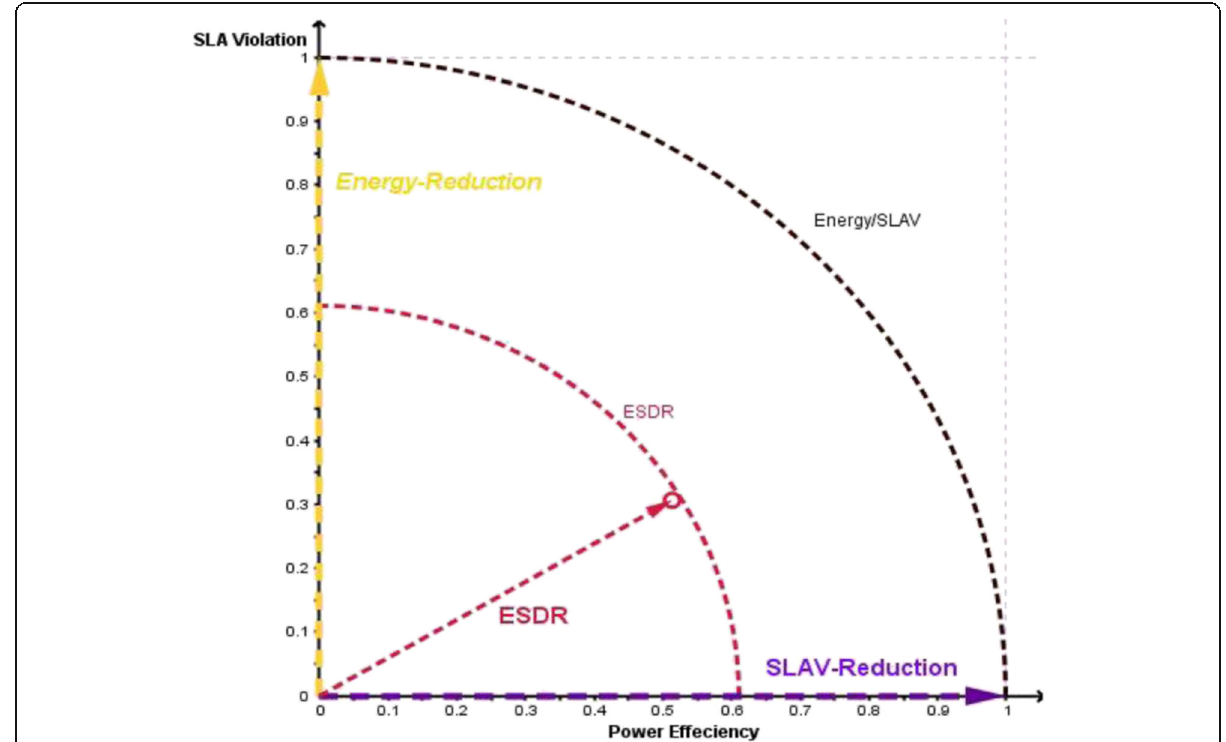
Fig. 7 Euclidean vector representation of scores for different